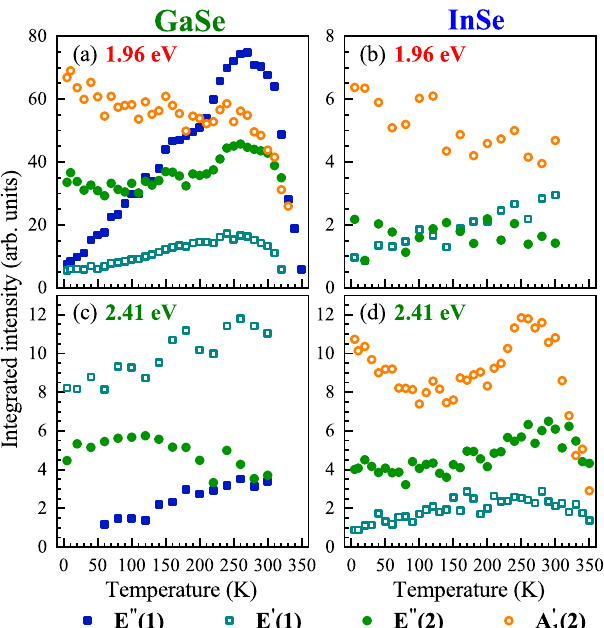
Figure 3. Temperature dependence of the Stokes-related phonon-modes intensities of ( a ),( c ) GaSe and ( b ),( d ) InSe under excitation of ( a ),( b ) 1.96 eV and ( c ),( d ) 2.41 eV.